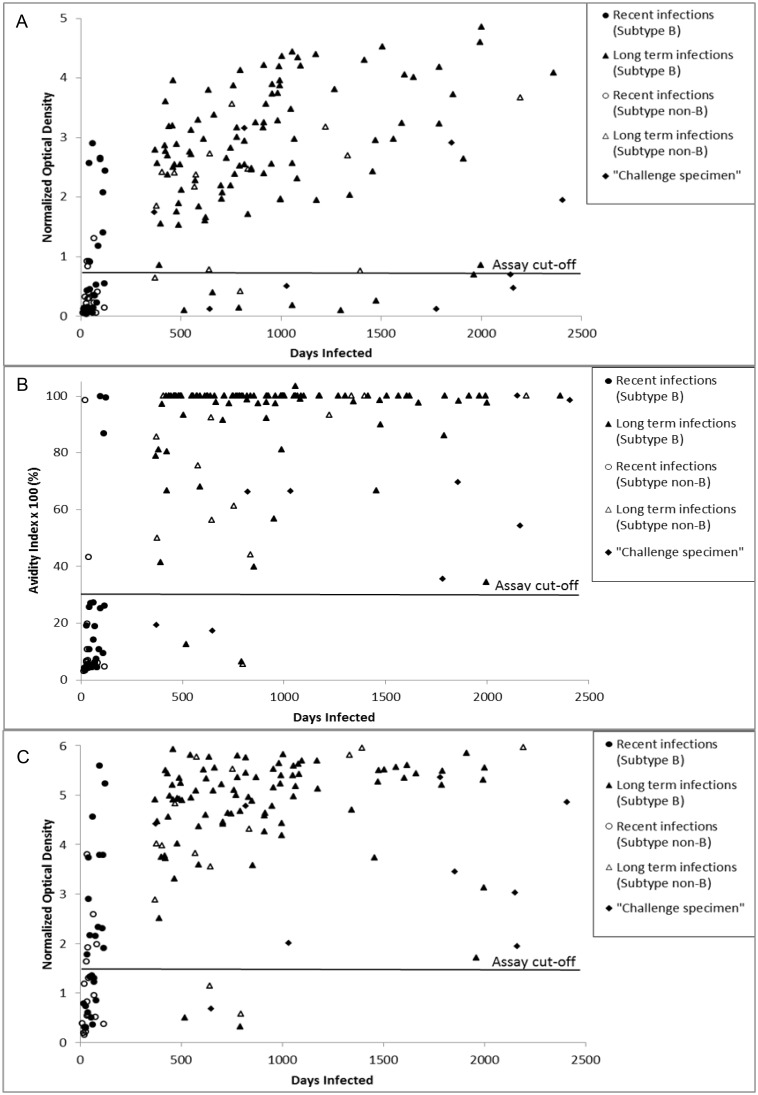
BED-CEIA, Bio-Rad Avidity and Lag-Avidity results according to duration of infection.Samples from the evaluation panel were analyzed using the BED capture enzyme immunoassay (A), Bio-Rad Avidity assay (B) and LAg-Avidity enzyme immunoassay (C). Respective assay cut-offs are indicated by the black line. Data are shown for subsets of the evaluation panel.